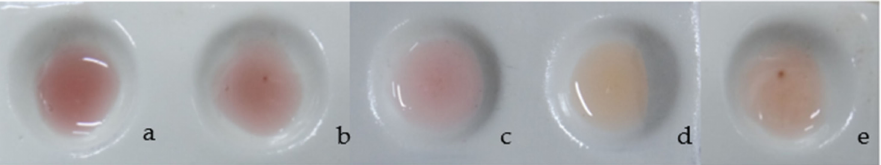
Figure 1. IAA production by LX-7:HT-1 = 1:2 ( a ), LX-7:HT-1 = 1:1 ( b ), LX-7:HT-1 = 2:1 ( c ), LX-7 ( d ) and HT-1 ( e ).